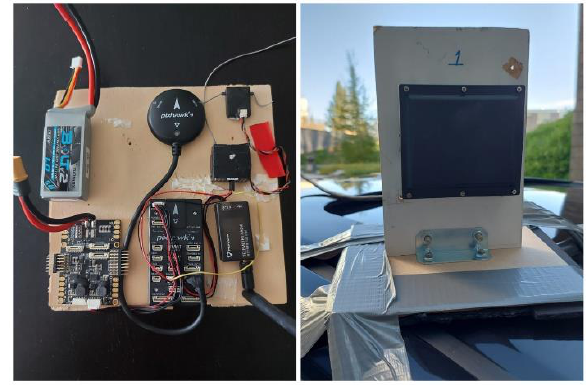
Figure 4. The Pixhawk 4 board and UMRR-11 Type 132 Radar unit.